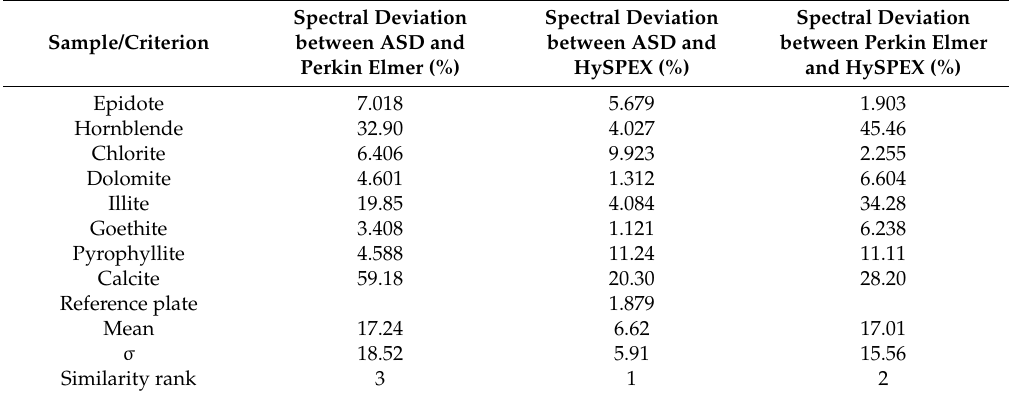
Table 6. Subjective evaluation of the spectral performance for the continuum removed